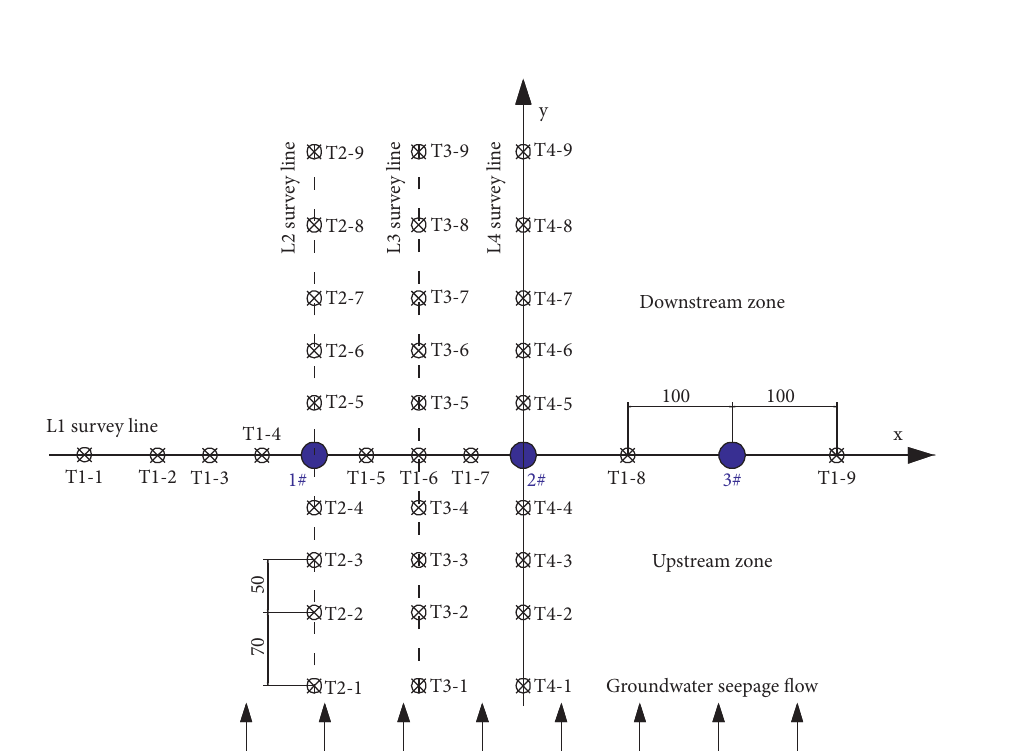
Figure 4: Arrangement of temperature sensors and freezing pipes.